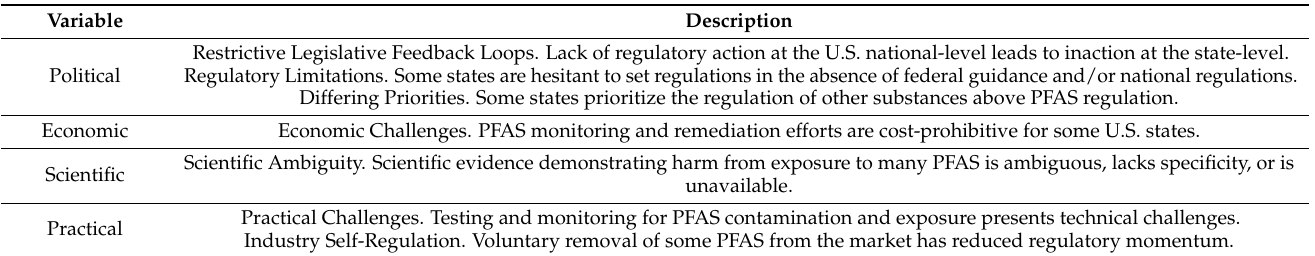
Table 5. Variables and sub-variables that drive away from the adoption of PFAS-related laws, policies, and regulations. Variable Description